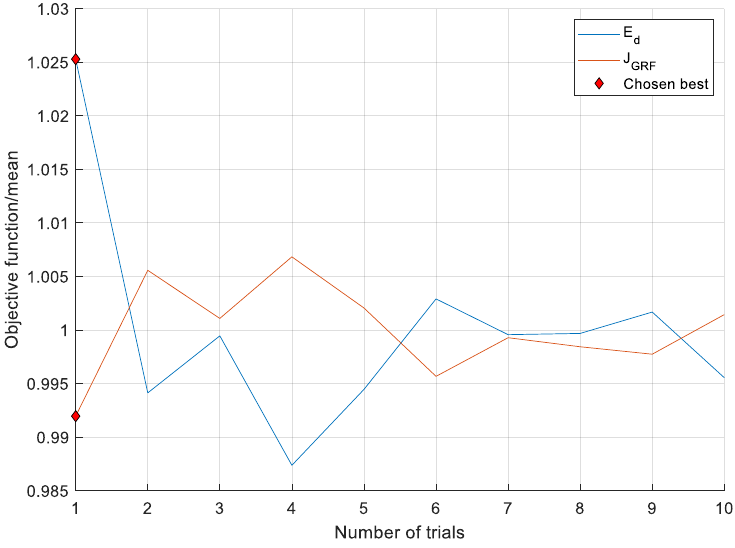
Figure 14. Comparison of fitness functions over the mean value between 10 trials. Eventually, a comparison between the cumulative mechanical energy of the experimental and numerical optimization data is shown in Figure 15. For the experimental campaign [34], a group of horses with a weight ranging between 417 and 673 kg, was used. For each animal, ten sequences were considered within the speed range from 0.7 to 1.9 m/s. Five markers, positioned along the horses’ backbones, identify the vertical and longitudinal motion of their center of mass ( CoM rigid ). The considered mechanical energy is defined by the expression (a special case of expression (29)):